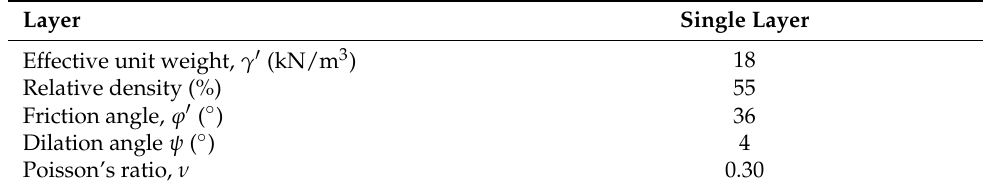
Table 4. Pile and superstructure properties used in the numerical